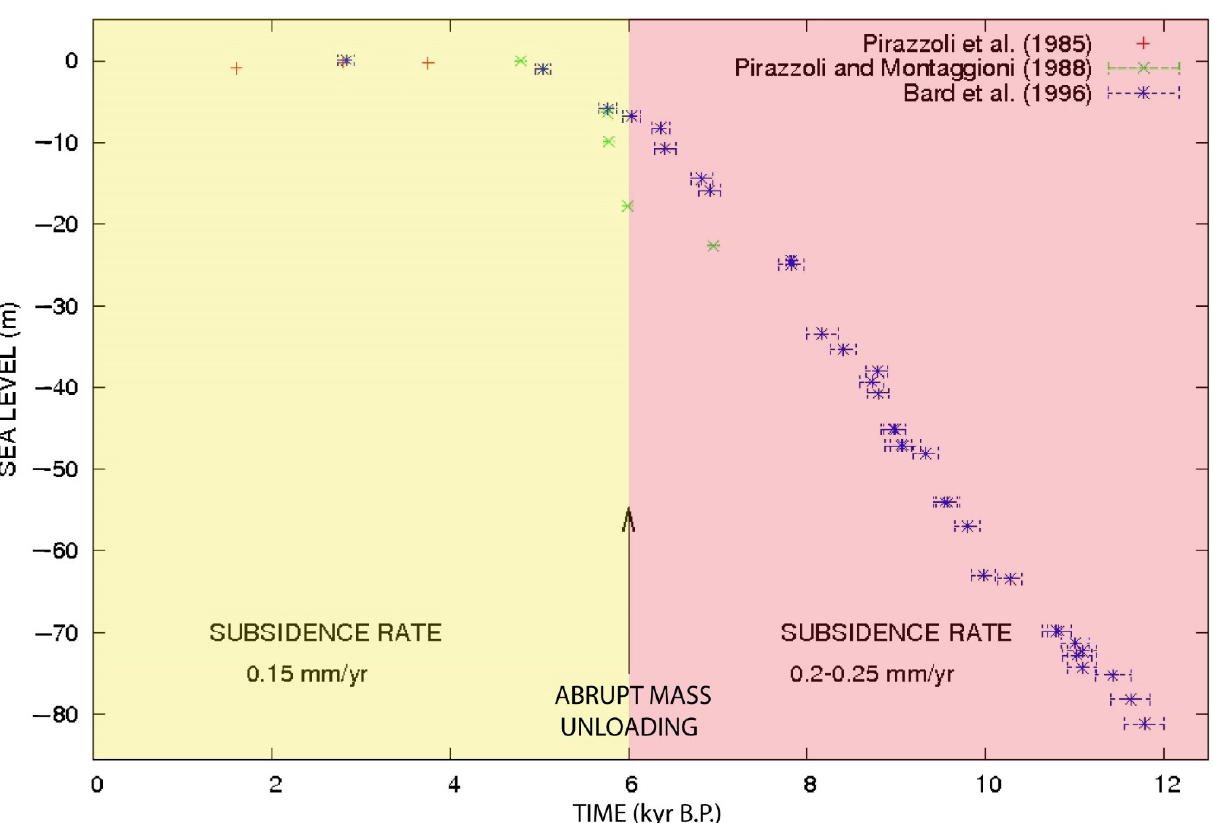
Figure 8. Schematic effect of an abrupt mass unloading, ( a ) on vertical motion rate, and ( b ) on relative sea level in the case of subsidence (green dotted line) or uplift (red dotted line).